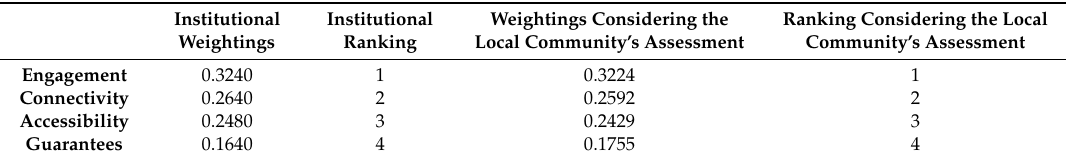
Table 6. Weightings and institutional ranking; weightings and ranking considering the local community’s assessments of the governance